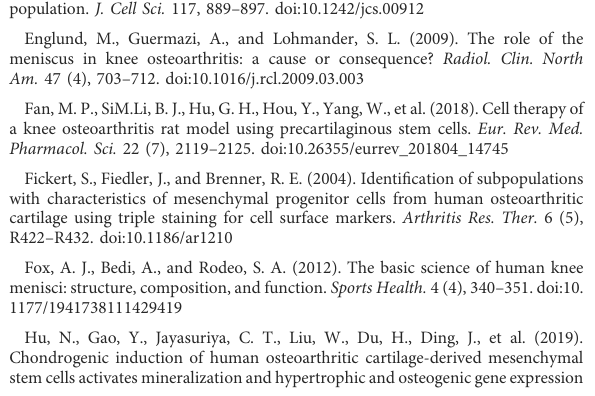
SUPPLEMENTARY FIGURE S1 Side-by-side comparison of the cell surface marker pro fi les of the stable BM-MSC line (BM-MSCL) and primary BM-MSCs. Cell surface marker expression rates of (A) Fibronectin, (B) Thy-1, (C) Endoglin, (D) ALCAM, and (E) ICAM1 in BM-MSCL and primary BM-MSCs. Primary BM-MSCs were obtained from American Type CultureCollection, which dispenses cells collected from healthy human tissues. The empty peaks represent isotypic controls, for reference. Percent values indicated in the graphs represent positive staining rate, above isotype control, for each individual CD marker. SUPPLEMENTARY FIGURE S2 Comparison of chondrogenic marker expression and cell proliferation capacities of BM-MSCL and primary BM-MSCs . Fold differences in the mRNA expression of (A) SOX9 , (B) COL2A1 , and (C) COL1A1 between primary BM-MSCs and the stable BM-MSC line, BM-MSCL. N ≥ 4 per group. ****, P ≤ 0.0001. (D) Cell proliferation assay results showing the proportion of proliferating cells in BM-MSCL cultures and primary BM- MSC cultures. SUPPLEMENTARY FIGURE S3 Off-targetengraftmentofstablehuman celllines wasnot detectedinthe major organs of cell-treated athymic rats. Agarose gel electrophoresis was used to con fi rm that human DNA was absent in major organs that are common targets for cell engraftment and metastasis. Tissues from cell-treated animals were homogenized and the total DNA was used as templates for PCR ampli fi cation of the human mitochondrial cytochrome C gene. DNA that was directly extracted from each line was subjected to the same procedure described above and used as internal positive controls. Observed bands are marked with arrows. DNA ladder is labeled with “ L ” . Data is representative of results observed in all experimental animals in each respective cell-treatment